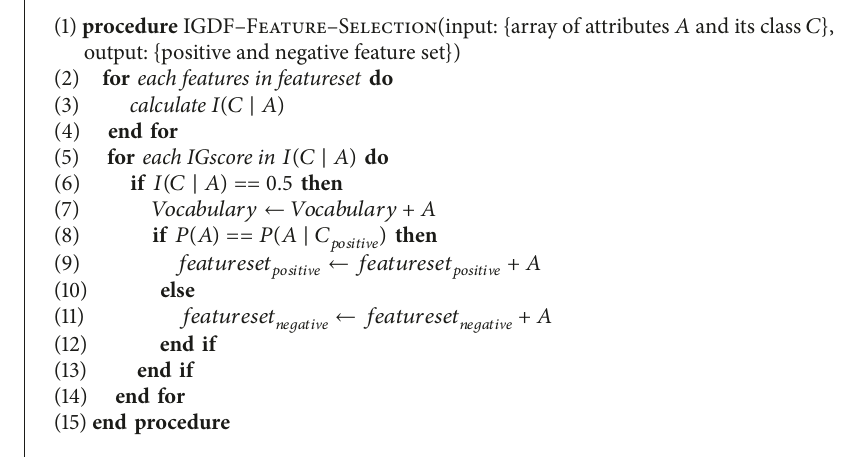
Algorithm 1: IGDF feature